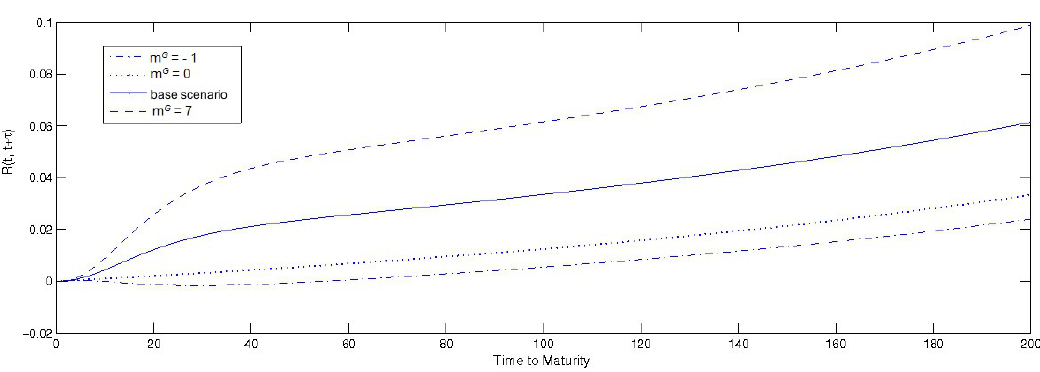
Figure 13. Short yield to different government